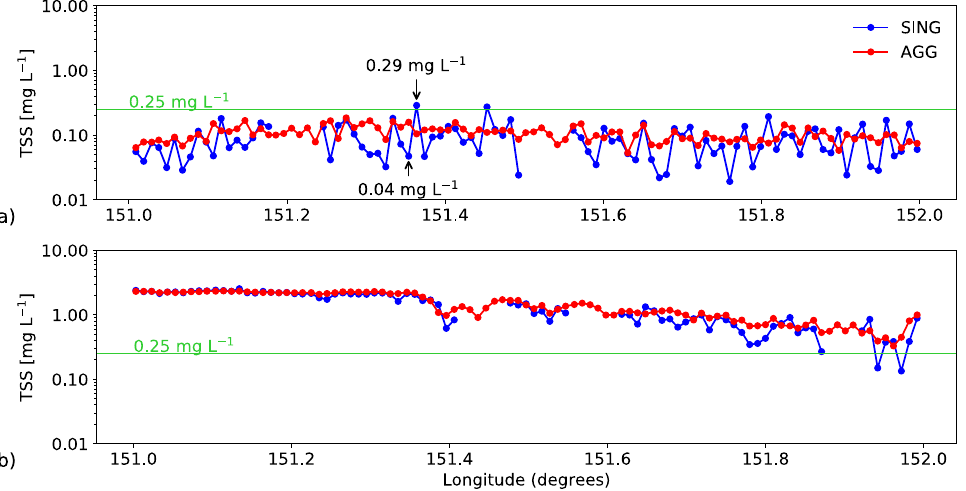
Figure 13. Transects of Himawari-8-derived TSS (mg L − 1 ) taken in the Coral Sea ( a ) and within the coastal GBR waters ( b ) from TSS SING (blue dots) and TSS AGG (red dots). The data gaps represent pixels masked for clouds, land, sun glint, or ANN flags, where appropriate. The annotated TSS (in black arrows) indicate pixel-to-pixel values and the green horizontal line marks the detection limit of the method.